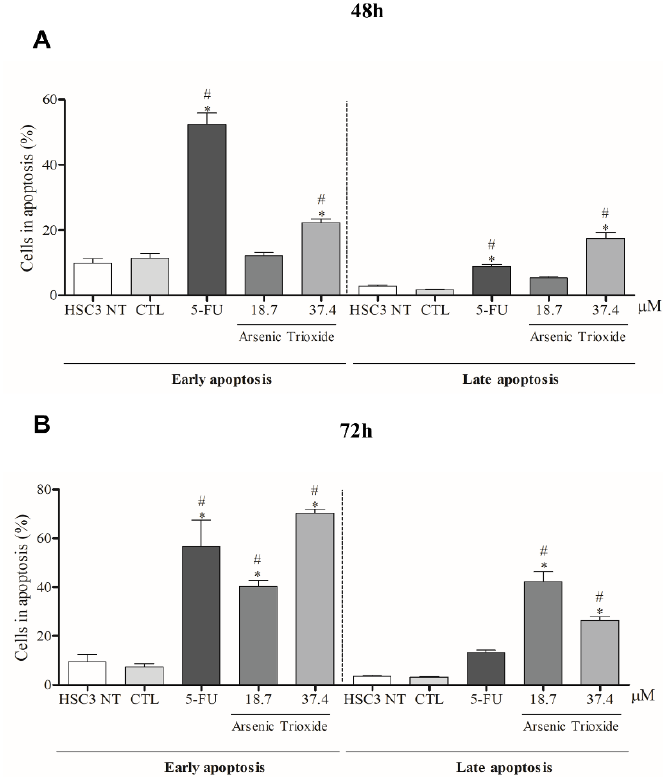
Figure 3. The effects of ATO on the externalization of phosphatidylserine in HSC3 cells, determined by flow cytometry using Annexin V-FITC/Propidium iodide (Early apoptosis/Late apoptosis), after 48 ( A ) and 72 h ( B ) of treatment. Cellular debris was omitted from the analyses and 10,000 events were analyzed per sample. (*) p ≤ 0.05 when compared to the negative control (CTL) and (#) when compared to the HSC3 NT group (non-treated cells) by ANOVA (analysis of variance) followed by Student Newman-Keuls test.